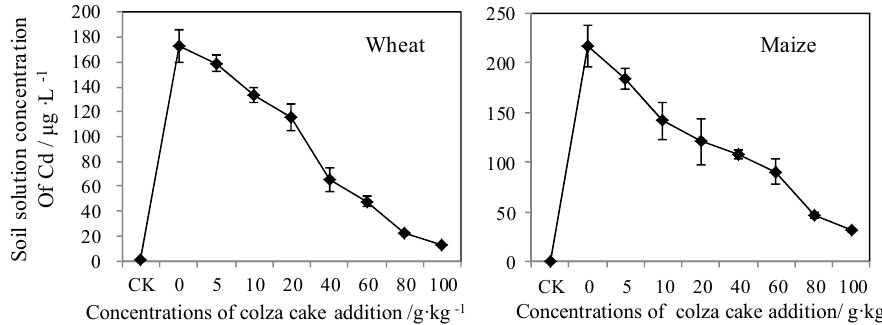
Figure 6. Soil solution concentrations ( C sol ) of Cd after the addition of colza cake in Cd-contaminated soils grown by wheat and maize, respectively.